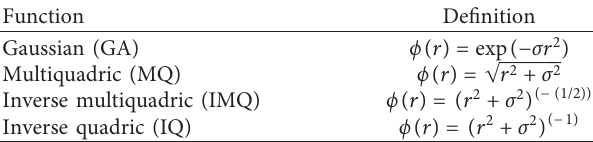
Table 1: Well-known functions generating RBF. Function Definition Gaussian